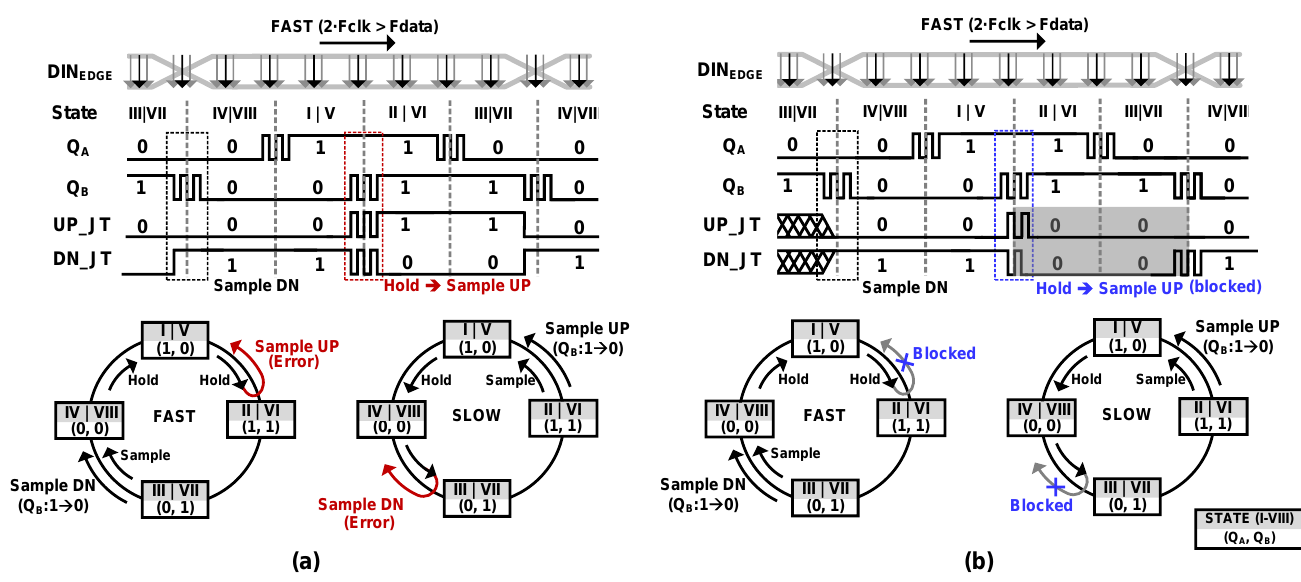
Figure 4. State model and state diagram of ( a ) a conventional half-rate DQFD with input jitter; ( b ) the proposed half-rate DQFD with input jitter.